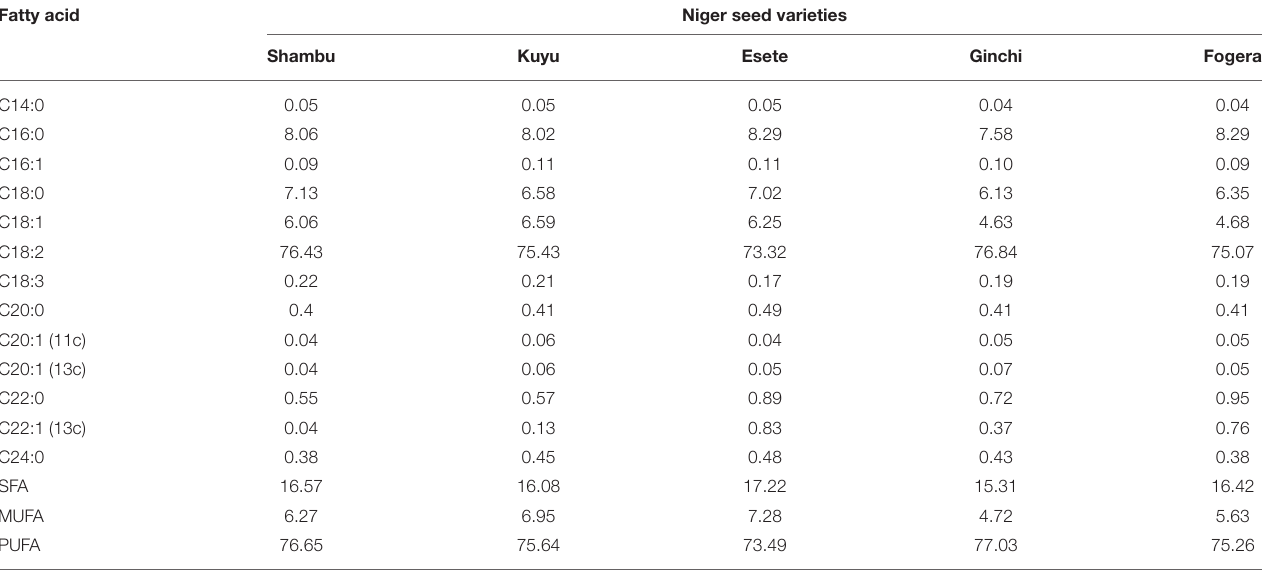
TABLE 1 | Fatty acid composition (%) of the different niger seed varieties. Fatty acid Niger seed varieties Shambu Esete Ginchi